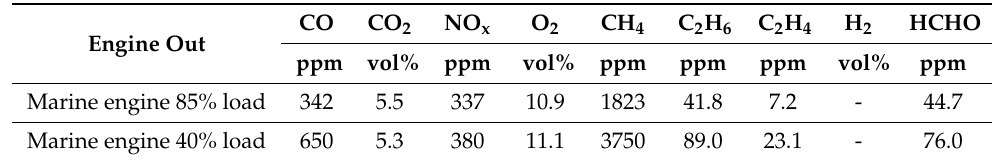
Table 2. Engine out exhaust gas composition from one medium speed dual fuel marine engine run with natural gas as the main fuel